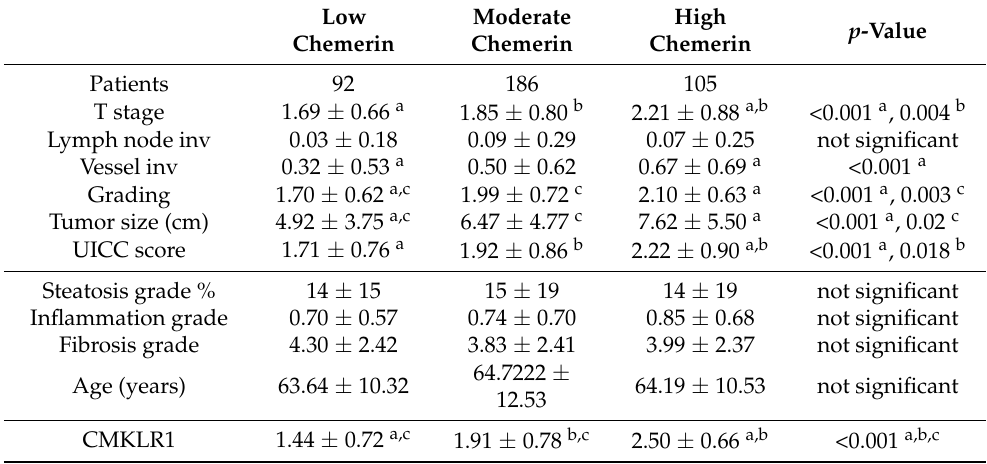
Table 1. T stage, lymph node invasion, vessel invasion, grading, UICC stage, steatosis, inflammation, fibrosis stages, age, and CMKLR1 scores of patients stratified for low, moderate, and high chemerin protein levels in the tumors. a: comparison of tumors with low and high chemerin, b: comparison of tumors with moderate and high chemerin, and c: comparison of tumors with low and moderate chemerin (inv, invasion). Low Moderate High p -Value Chemerin Chemerin Chemerin Patients 92 186 105 T stage 1.69 ± 0.66 a